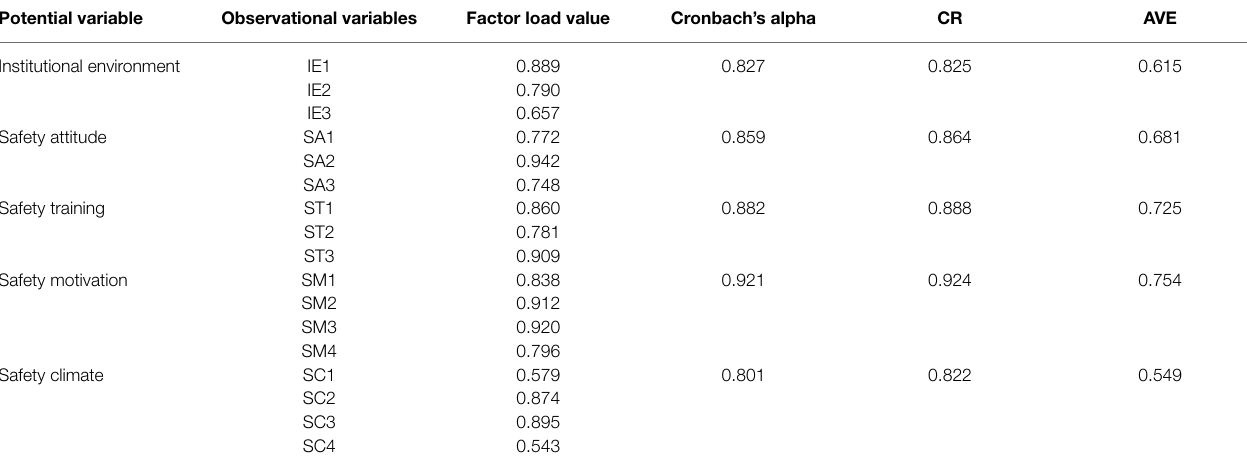
TABLE 4 | Reliability and validity analysis